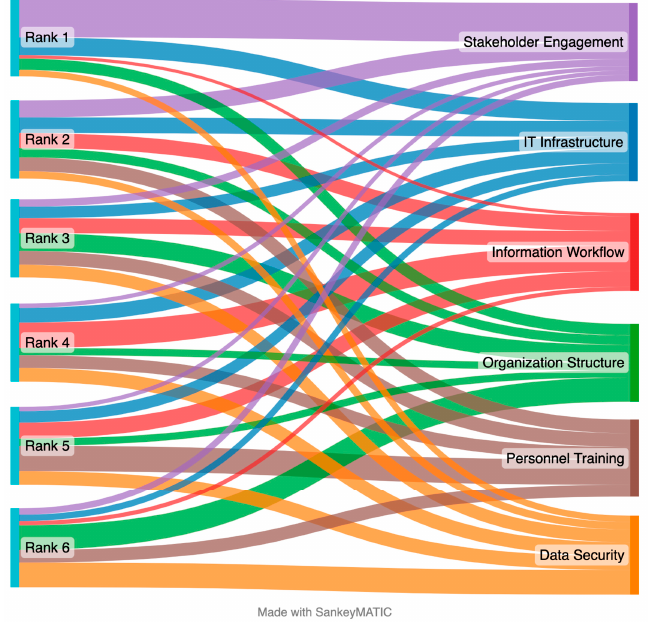
Figure 2. Ranking of six technology implementation factors using the Sankey diagram ( n = 74).